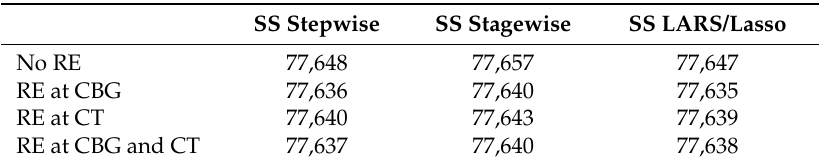
Table 11. AIC comparisons among spatial scale (SS) forward stepwise, forward stagewise, and LARS/lasso models with varying random effects (RE): no RE, RE at CBG, RE at CT, and RE at CBG and